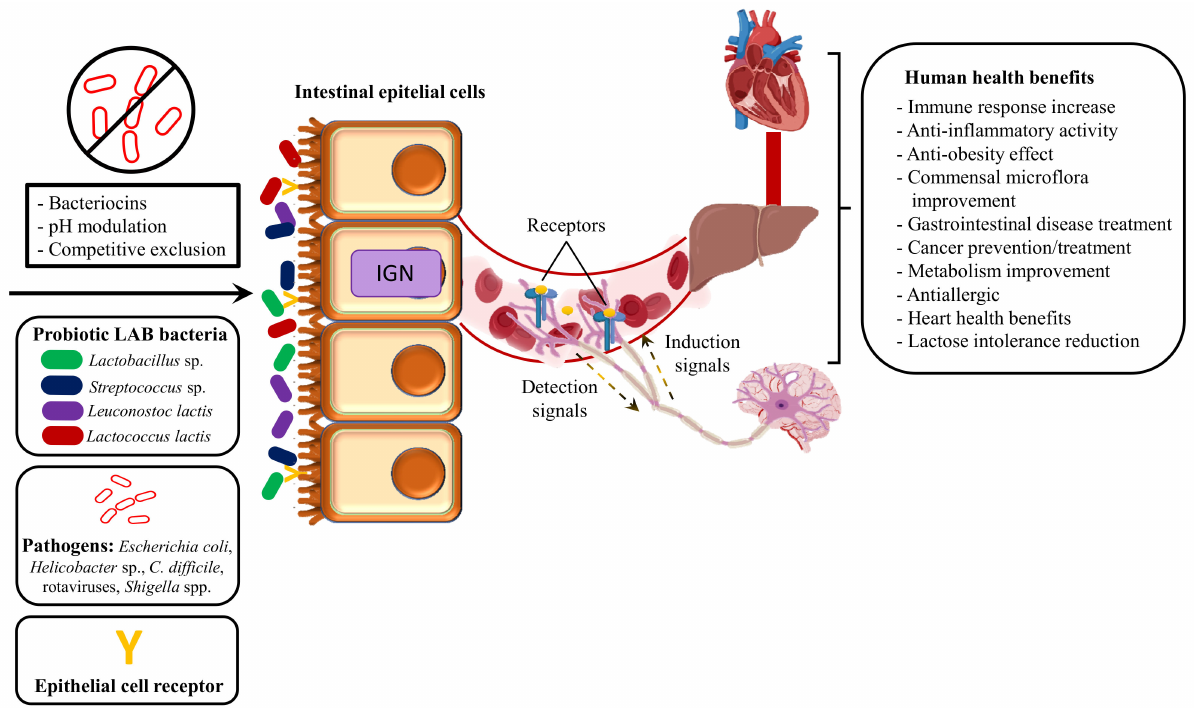
Figure 2. Mechanism of action and human health benefits from the main lactic acid bacteria (LAB) isolated from raw buffalo milk ( Lactobacillus sp.: L. plantarum , L. paracasei , L. fermentum , L. delbrueckii ; Streptococcus sp.: S. thermophilus , S. macedonicus